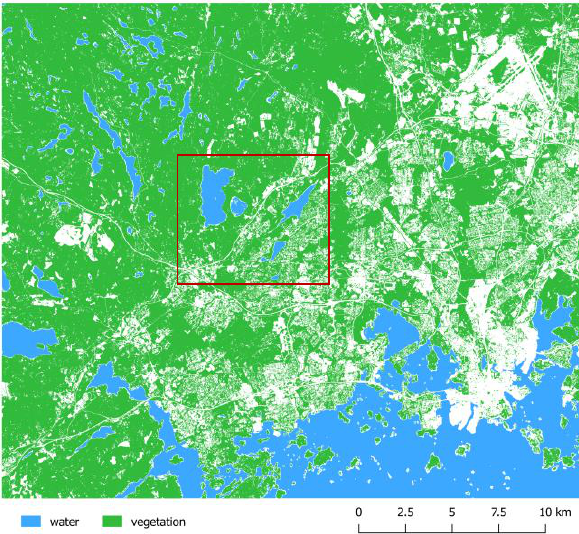
Figure 2: Resulting water and vegetation areas (white areas show class ‘other’) from indices of the whole test site, extracted from Sentinel-2 image from 17.08.2015. Red square indicates location of Figure 3.